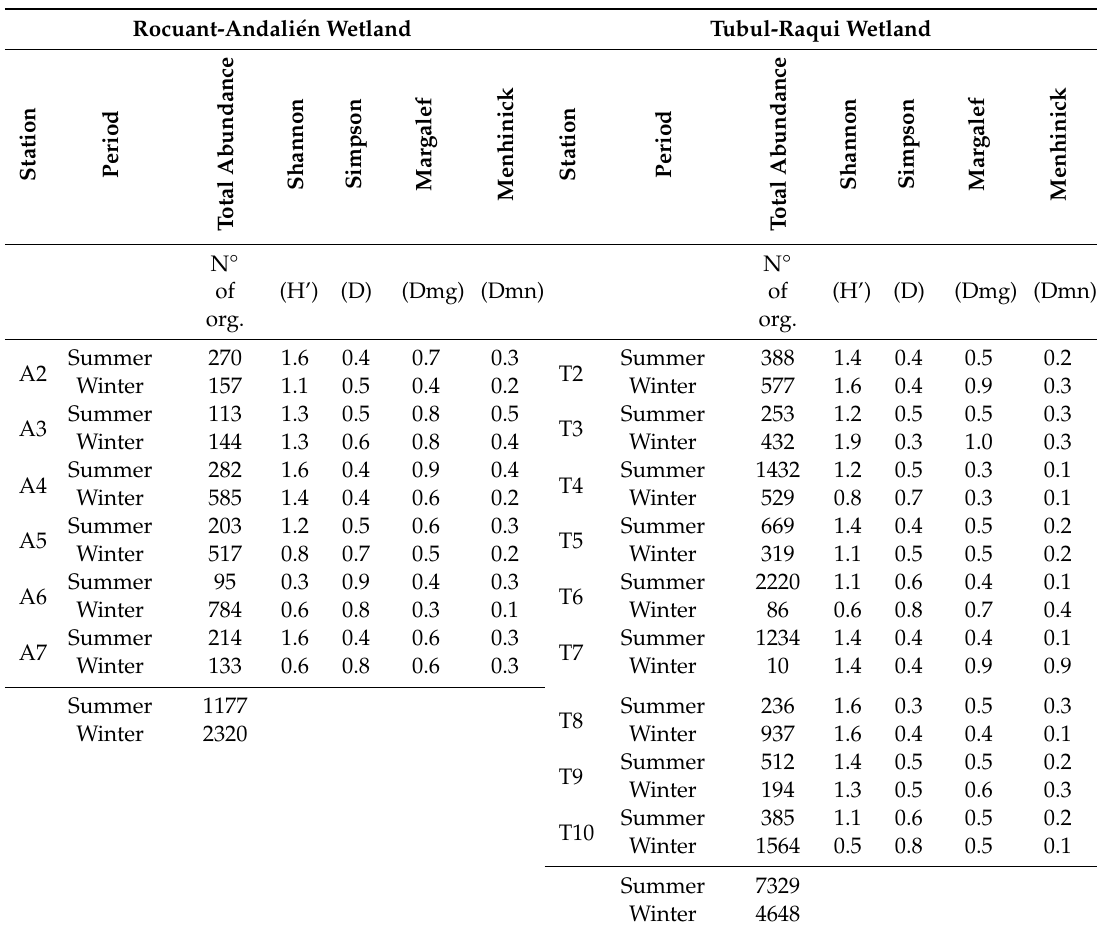
Table 2. Total population abundance, Shannon–Wiener diversity index (H’), Simpson’s index (D), richness of species according to the Margalef (Dmg) and Menhinick indices (Dmn) of the macroinvertebrates in the Rocuant-Andali é n wetland ( n = 7) and Tubul-Raqui wetland ( n = 10) during summer and